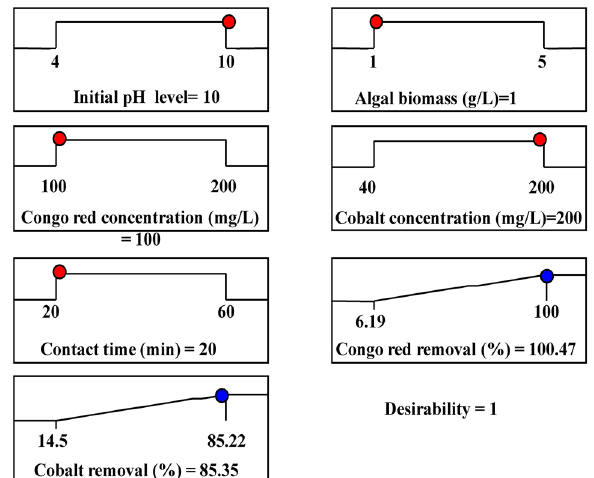
Figure 5. The optimum predicted values and the desirability function for the maximum percentage of cobalt and Congo red dye biosorptionusing E. intestinalis biomass.